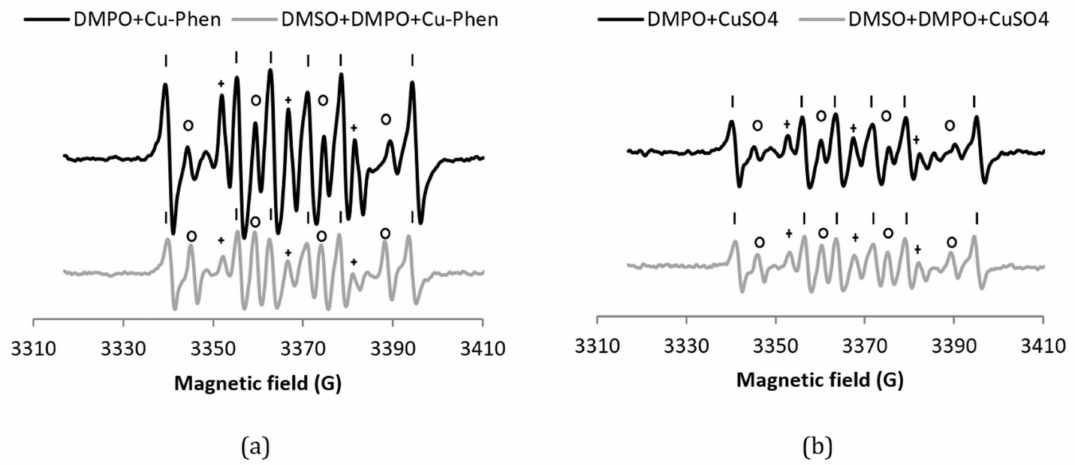
Figure 3. X-band EPR spectra of ( a ) DMPO + Cu–Phen and DMSO + DMPO + Cu–Phen; ( b ) DMPO + CuSO 4 and DMSO + DMPO + CuSO 4 .The simulations revealed the presence of at least three radical species in each case. With DMPO + Cu–Phen (exp 2): DMPO–OH, a N = 15.088 G, a H = 14.943 G; DMPO–R, a N = 15.781 G, a H = 23.27 G; “triplet radical”, a N = 14.354 G. With DMSO + DMPO + Cu–Phen (exp 13): DMPO–OH, a N = 14.697 G, a H = 13.82 G; DMPO–R, a N = 15.488 G, a H = 22.635 G; “triplet radical”, a N = 14.305 G. With DMPO + CuSO 4 (exp 1); DMPO–OH, a N = 15.798 G, a H = 14.928 G [33,34]; DMPO–R, a N = 15.798 G, a H = 23.237 G [35]; “triplet radical”, a N = 14.609 G; other, a N = 16.323 G, a H = 26.653 G (uncertain). With DMSO + DMPO + CuSO 4 (exp 12): DMPO–OH, a N = 14.697 G, a H = 14.015 G; DMPO–R, a N = 15.439 G, a H = 22.586 G; “triplet radical”, a N = 14.354 G; Assignments: o = DMPO–OH, | = DMPO–R, + = “triplet